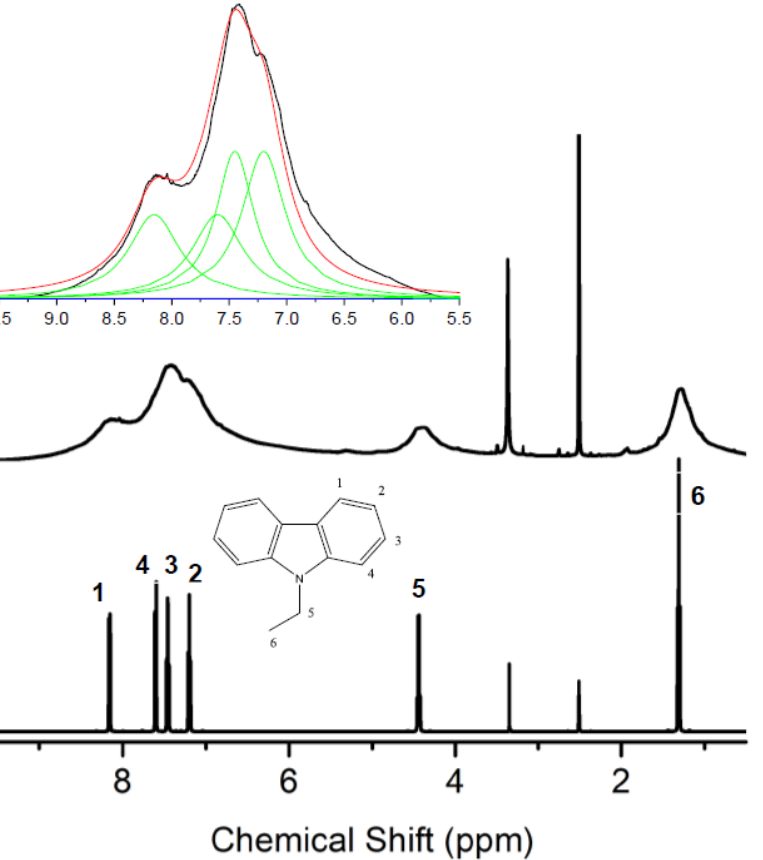
Figure 6. Proton NMR spectra of NEC-CDots (upper) and free NEC (lower), both in DMSO- d 6 . The sharp peaks around 3.3 ppm and 2.5 ppm are due to water and DMSO, respectively. Inset: Results from the deconvolution via curve fitting of the aromatic signals with the assumption that the four peak maxima are unchanged from those in the free NEC.